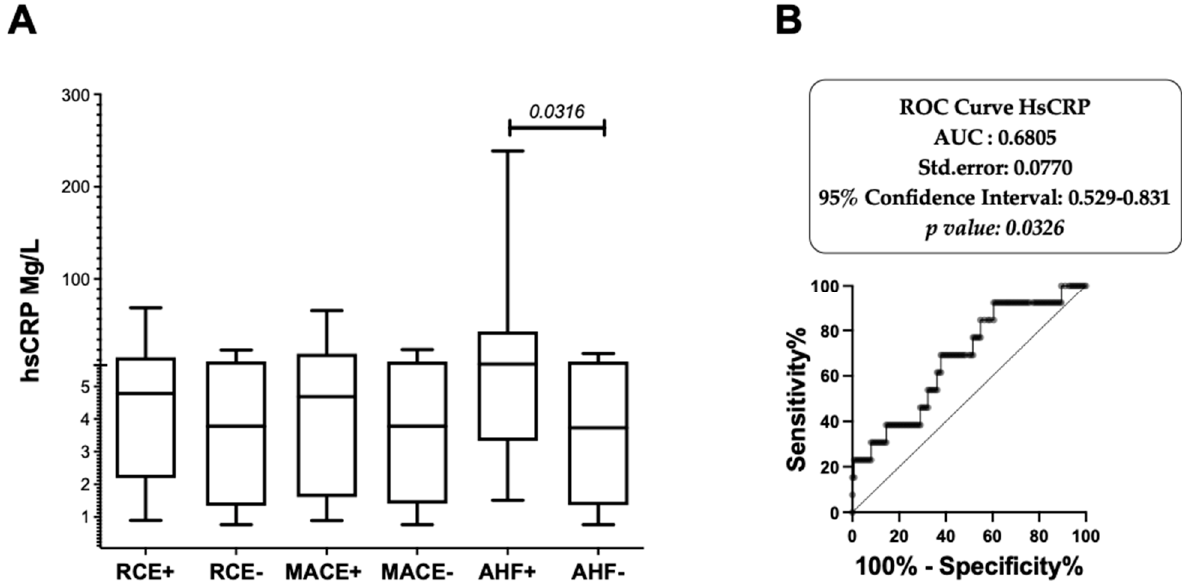
Figure 1. High circulating CRP levels are associated with AHF recurrence. ( A ) Comparative analysis of circulating hsCRP levels was analyzed in RCE (RCE+, n = 27) and non-RCE patients (RCE-, n = 118). HsCRP levels were then analyzed in the subgroups of patients experiencing MACE (MACE+ group, n = 18, among which 14 patients were MACE+AHF- and 4 patients experienced both MACE and AHF episodes during the first year post PCI) or AHF (AHF+ group, n = 13, 9 AHF+MACE- and 4 AHF+MACE+ patients) analyzed in reference to patients without MACE (MACE-, n = 127) or free of AHF (AHF-, n = 132) at one year post ACS. hsCRP variables are described in box and whiskers plots as medians and (10–90 percentile) using GraphPad Prism. Comparison between groups were performed using Mann–Whitney non-parametric unpaired t tests. p values < 0.05 were reported as significant. ( B ) ROC curve analysis of CRP levels associated with recurrent AHF episodes during the first year post initial ACS. Receiver operating characteristic (ROC) curves were used to define the best threshold value of hsCRP that allows us to discriminate patients with and without AHF, according to the Youden’s method (which allows for the maximization of both sensitivity and specificity).